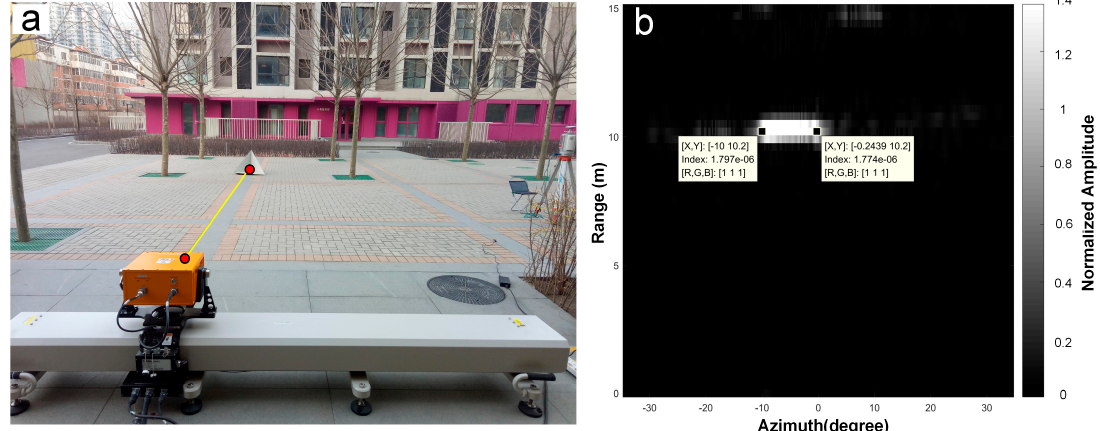
Figure 5. Another test for “artefact” using a 2 m GB-SAR. ( a ) shows the set up of the test, CR1 was about 10m from GB-SAR and ( b ) is the amplitude image of the CR which is shown as long bright spot.